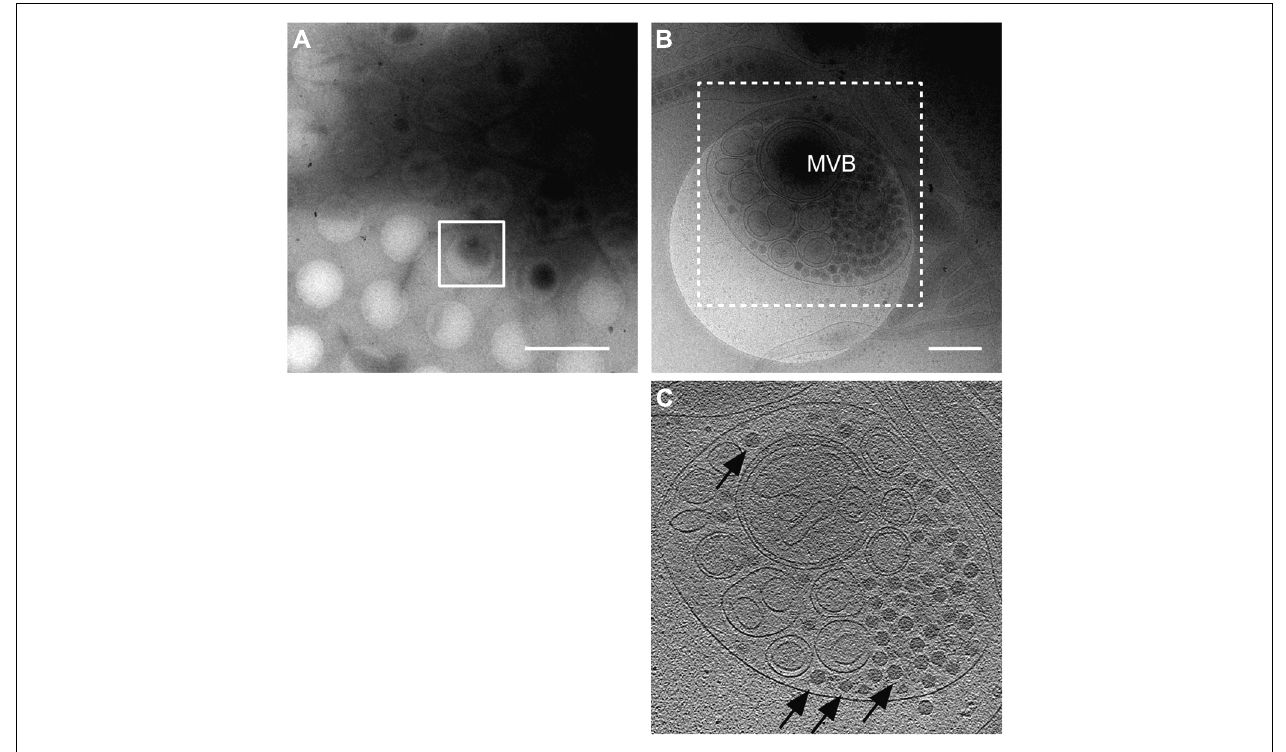
FIGURE 4 |Virus egress from infected insect cells. Cryo-electron microscopy (cryo-EM) images of a RDV-infected insect cell cultured on the EM grid. (A) Low magnification cryo-EM image of the RDV-infected insect cell cultured on the EM grid. Scale bar, 2 μ m. (B) High magnification cryo-EM